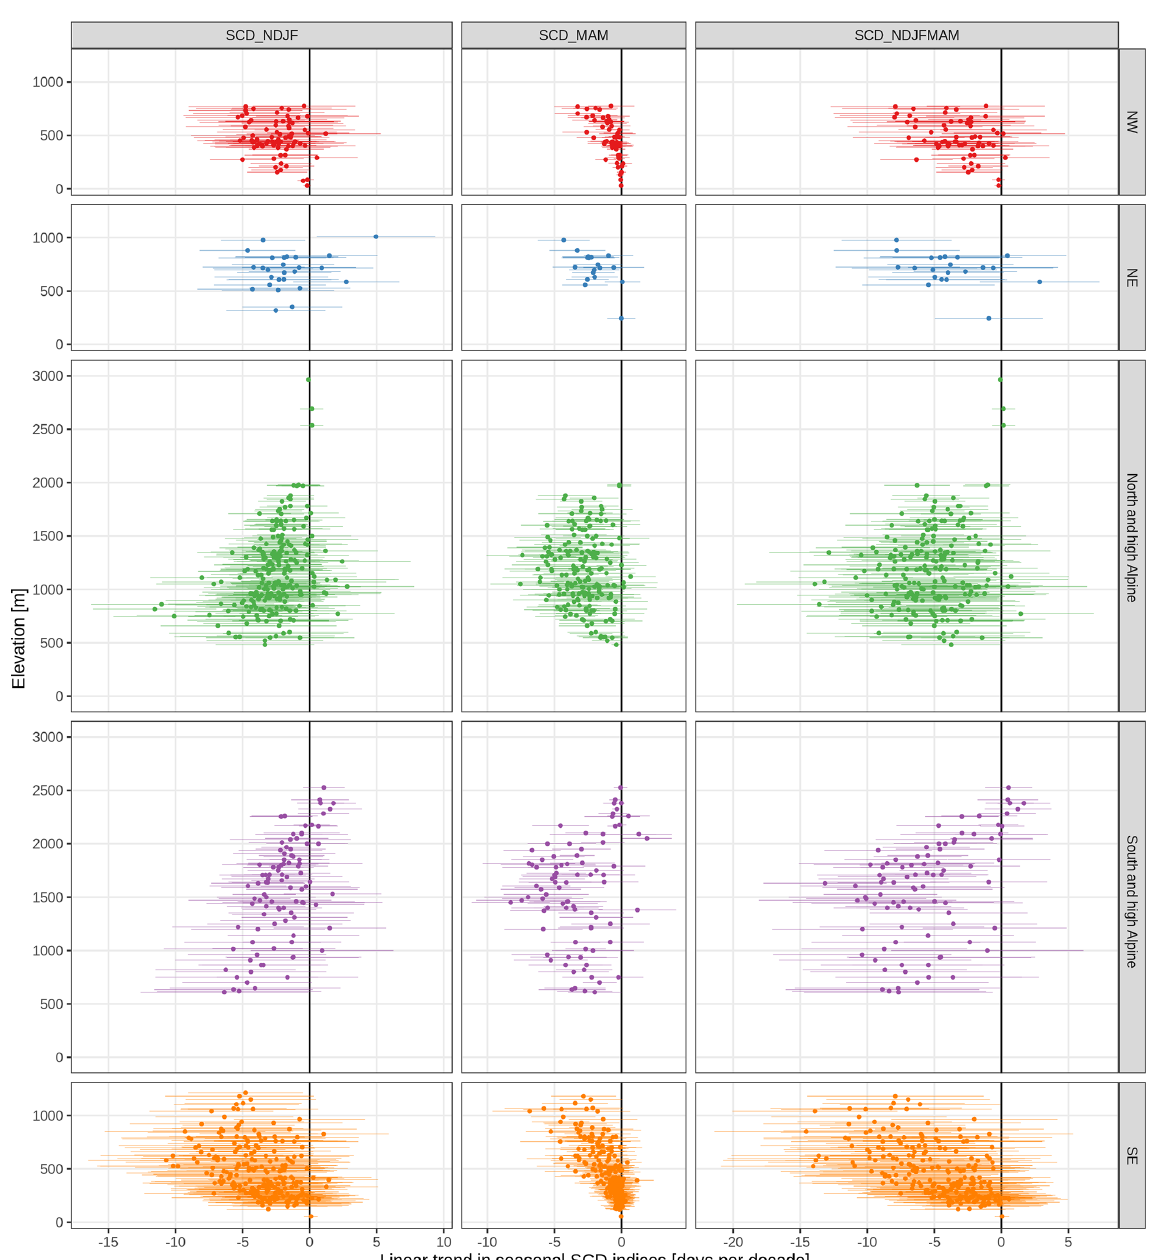
Figure C2. Long-term (1971 to 2019) linear trends in seasonal snow cover duration (SCD) indices. Trends are shown separately by index (columns) and region (rows). The season is indicated in the columns with the first letter of the included months (e.g. NDFJ is November, December, January, and February). Each point is one station. The points indicate the trend and the lines the associated 95% confidence